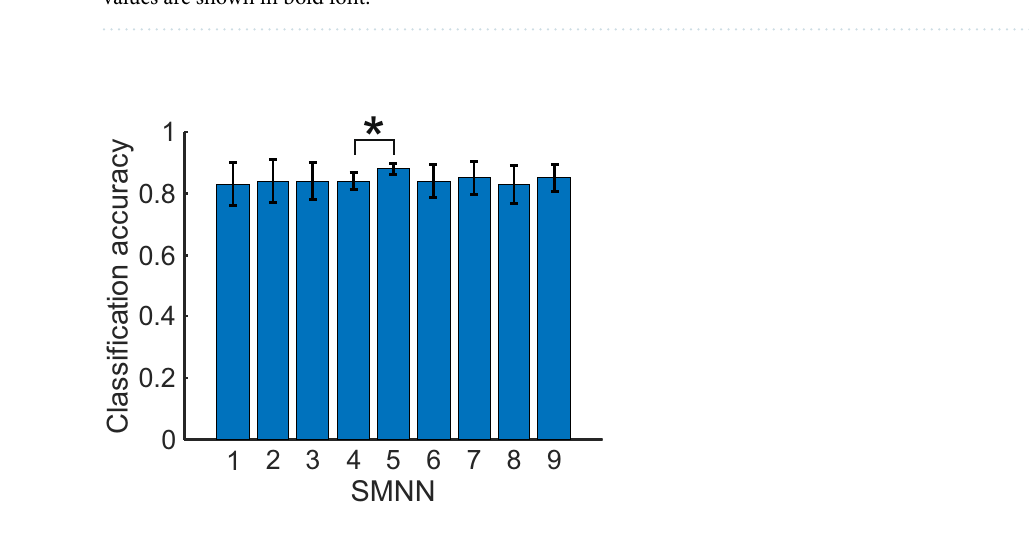
Table 4. Comparison of SMNN 1–9 architectures (see Table 3). Mean and standard deviation (in parenthesis) obtained on five cross-validation test sets (see Table 2) are shown for each model. Acc. - Accuracy. Best average values are shown in bold font.